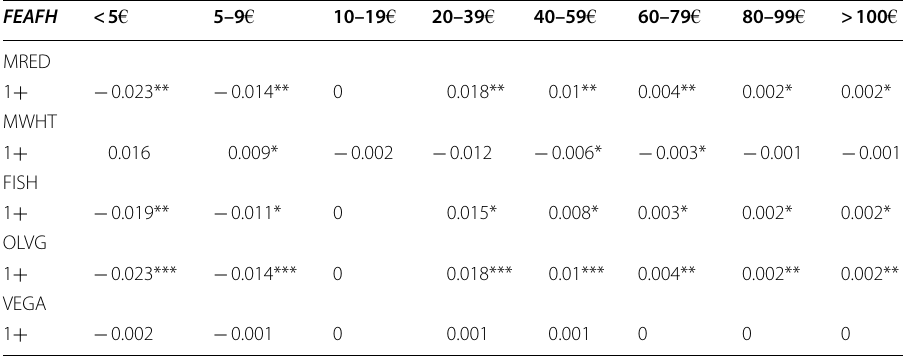
Table 8 Marginal effects of meals on food expenditure away-from-home FEAFH < 5